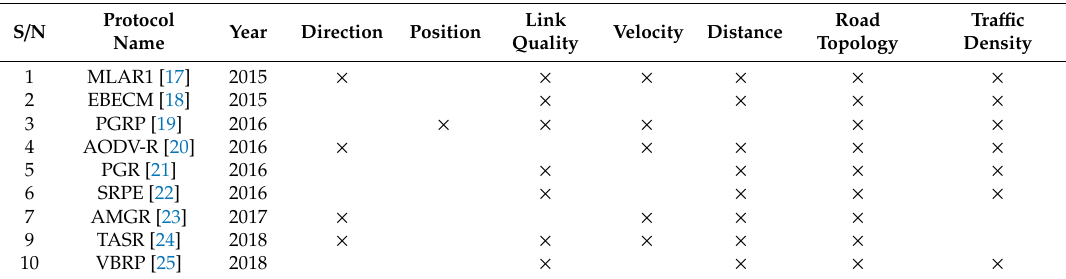
Table 1. Parameters for geographical routing protocols. PGRP: perception-based geographical routing protocol; AODV-R: ad hoc demand distance vector reliability; AMGR: analytical hierarchical process